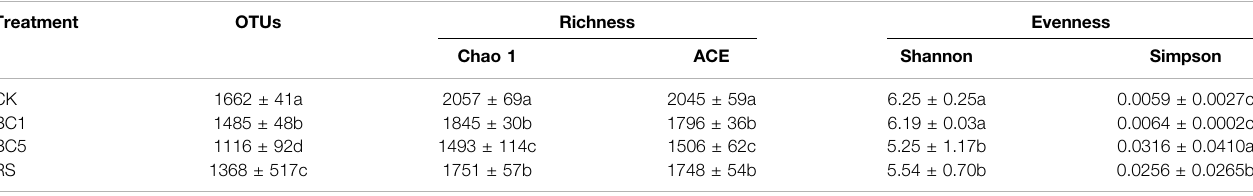
TABLE 2 | Numbers of operational taxonomic units (OTUs) and α -diversity indexes of soil bacteria.